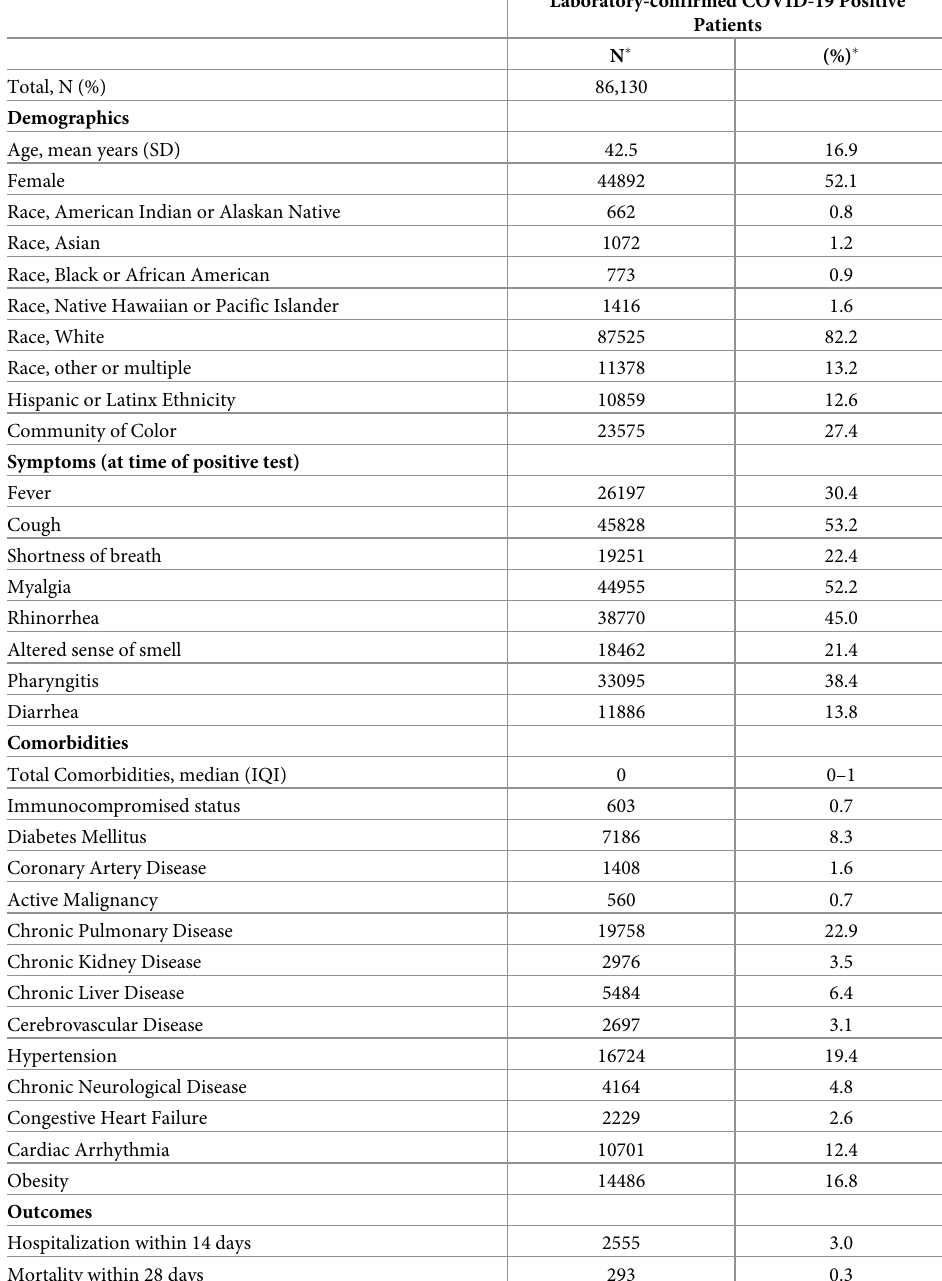
Table 2. Demographics and clinical characteristics of the temporally-independent validation